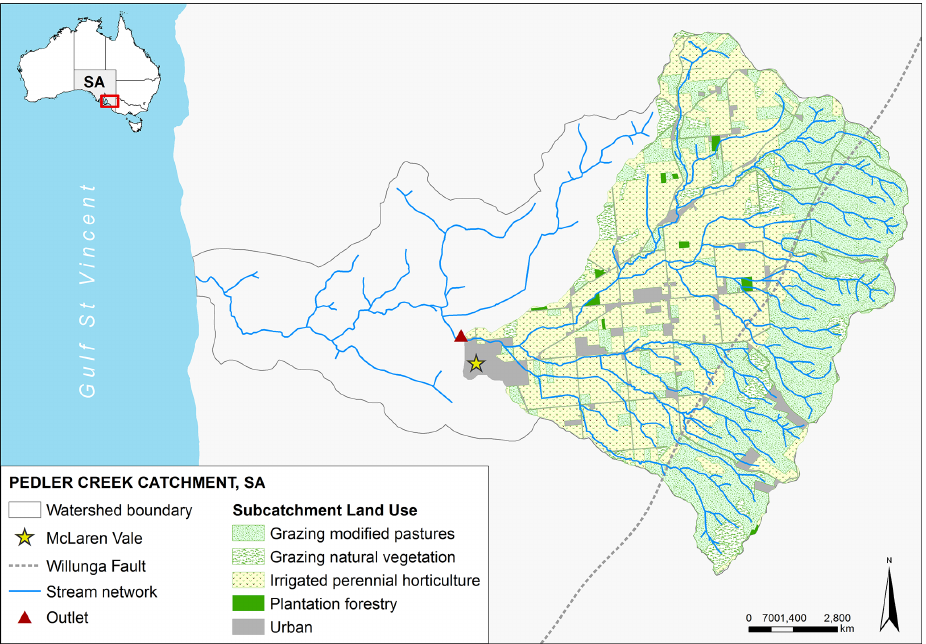
Figure 1. Pedler Creek catchment location showing the original watershed boundary, the stream network, and the Willunga Fault. The five major land uses are shown for the model sub-basin.